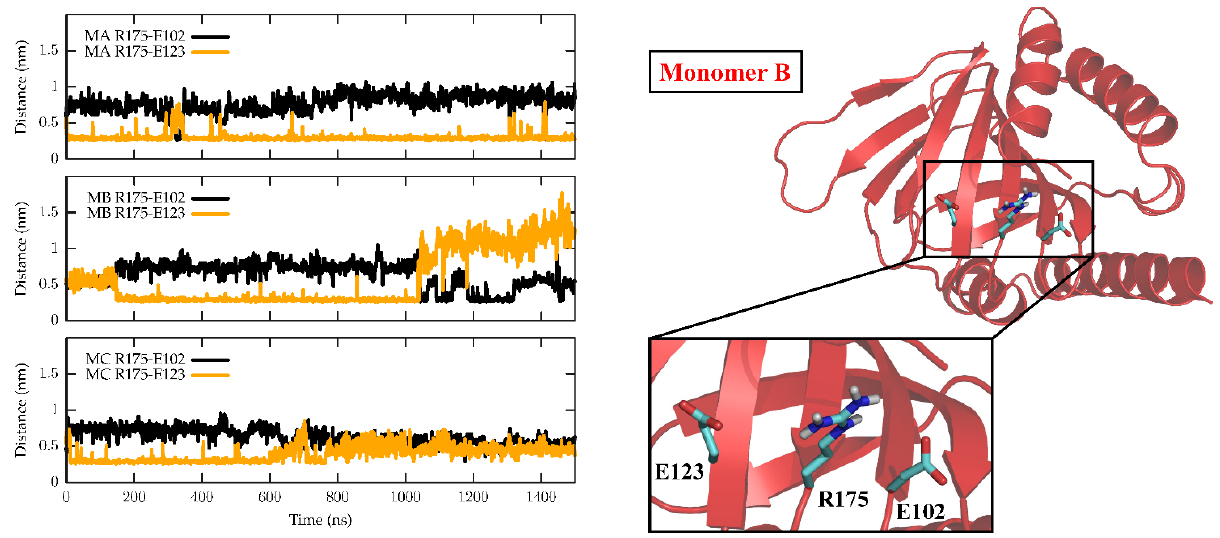
Figure 3. Time evolution of salt bridges between residues R175, E102 and E123 along the MD simu- lation. In the left panel, the minimum distances calculated between R175 and E102 (black) and be- tween R175 and E123 (orange) are reported as a function of the simulated time for the three mono- mers, namely M1 ( top panel), M2 ( middle panel) and M3 ( bottom panel). Right panel: cartoon rep- resentation of M2 in the starting conformation of the MD simulation, which is virtually identical to the crystallographic conformation. Zoomed-in inset: residues R175, E102 and E123 are shown as sticks and coloured by atom type: C, cyan; N, blue; O, red; H, white.